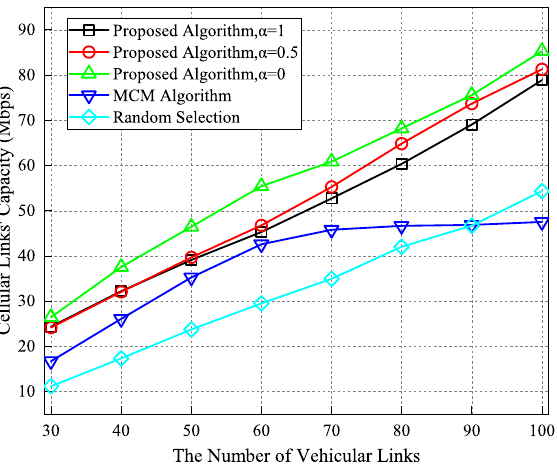
Figure 10. The total capacity performance of different schemes with varying V2V